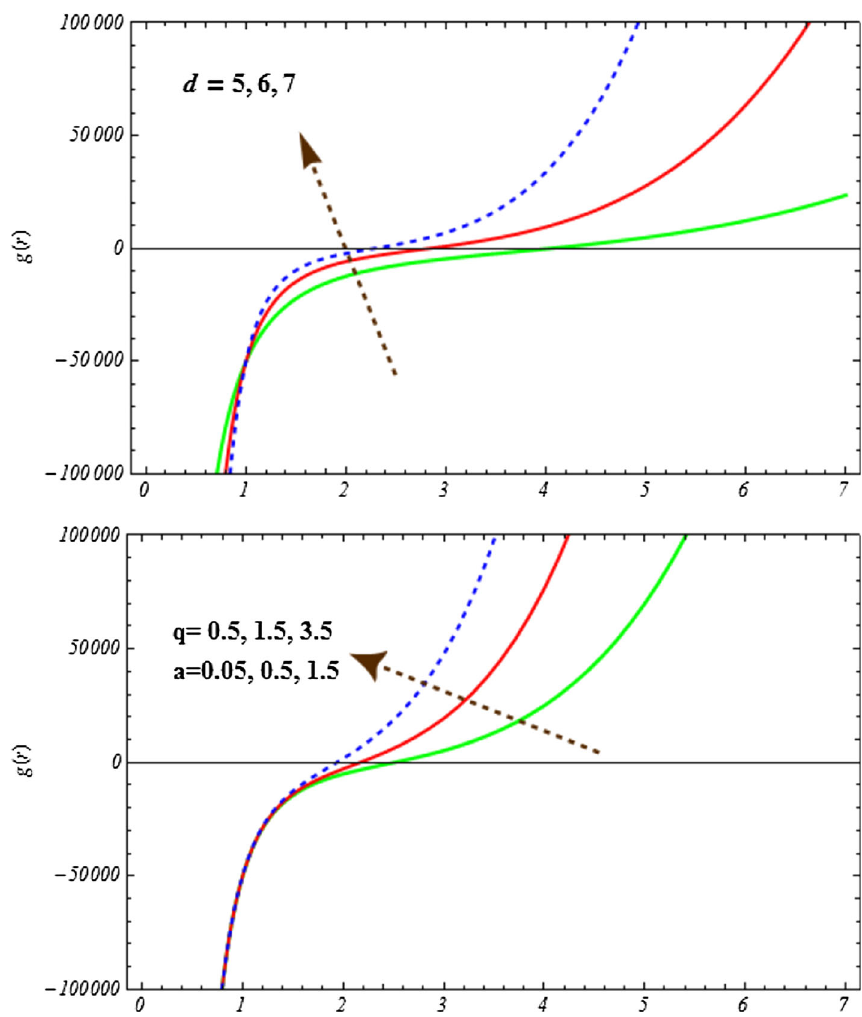
Fig. 1 The plot of g ( r ) (Eq. (2.28)) vs r for fixed values of l = 1, M = 10 3 , δ d , 2 n − 1 = 100, ω = − 0 . 7, (cid:13) = 1, q = 0 . 2, q d − 2